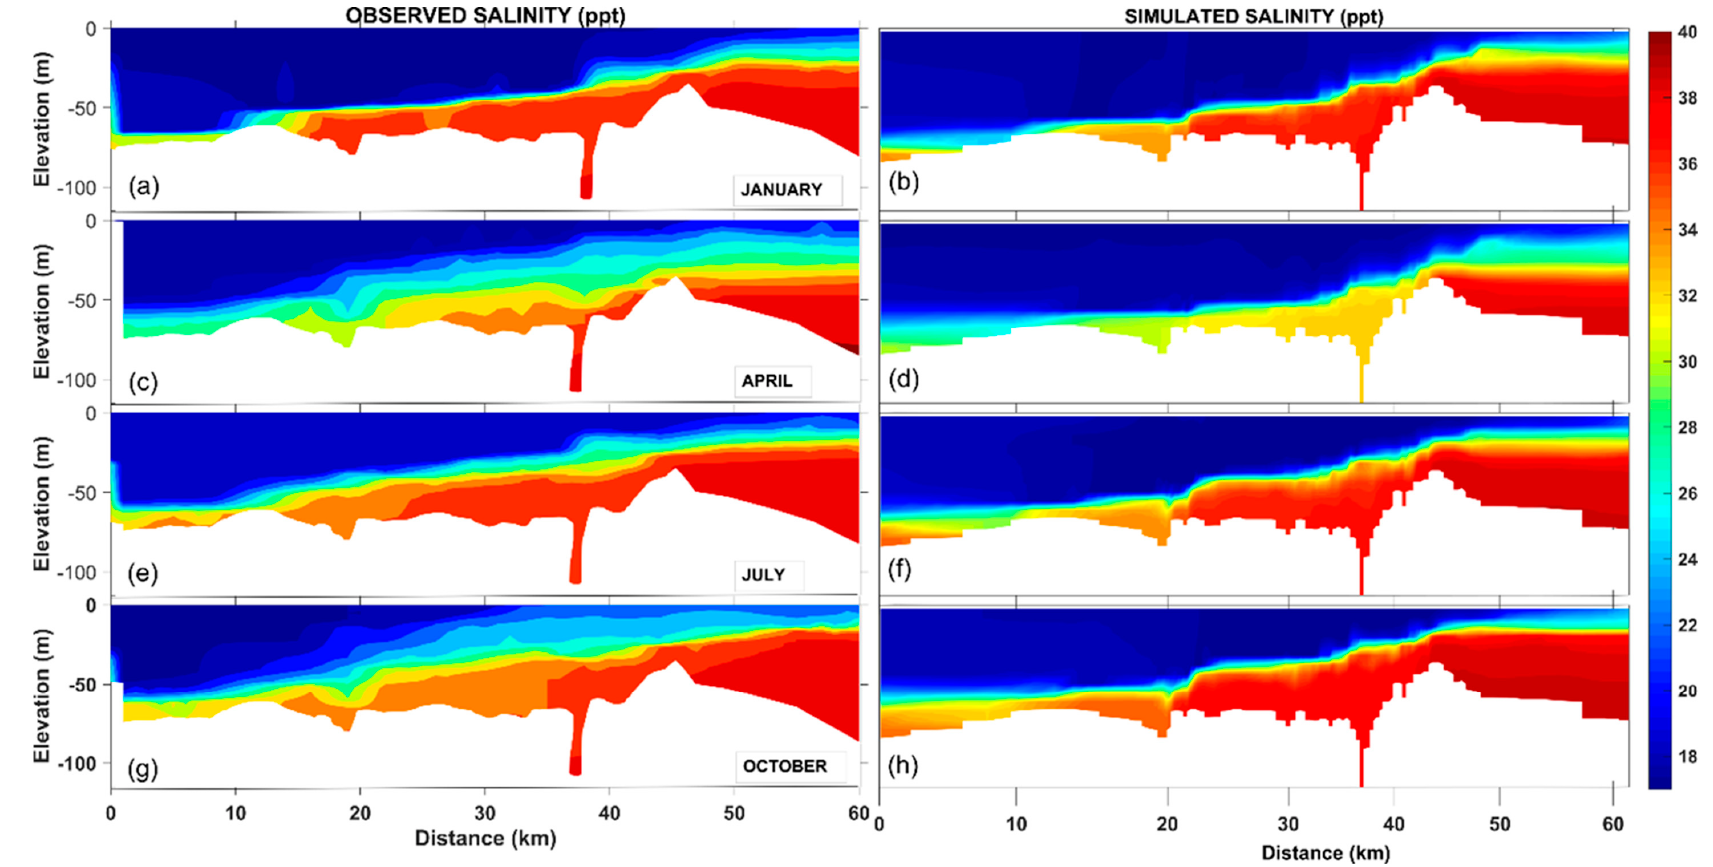
Figure 9. Salinity profiles observed ( a ) and modeled ( b ) in January, observed ( c ) and modeled ( d ) in April, observed ( e ) and modeled ( f ) in July, and observed ( g ) and modeled ( h ) in October.